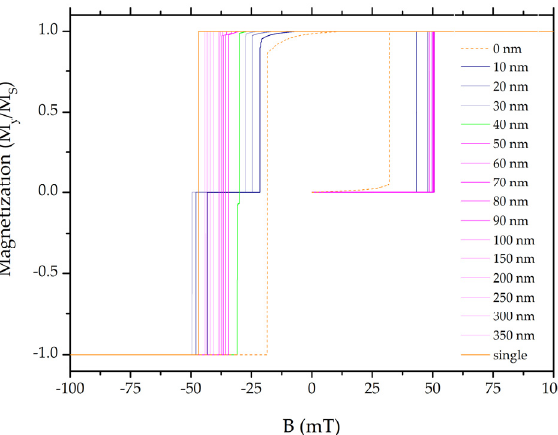
Figure 4. Evolution of the magnetization parallel to the long axes of the elongated diamond-shaped macrospins with varying intensity B with the external magnetic field for selected interparticle distances d . The starting point at B = 0 is the AF configuration. The largest hysteresis occurs for a single nanoparticle (FM → rFM). Similar colors correspond to particular types of switching behavior: magenta FM → rFM, green FM → AF → rFM and navy FM → dAF → rFM. The dashed orange line corresponds to the distance d =